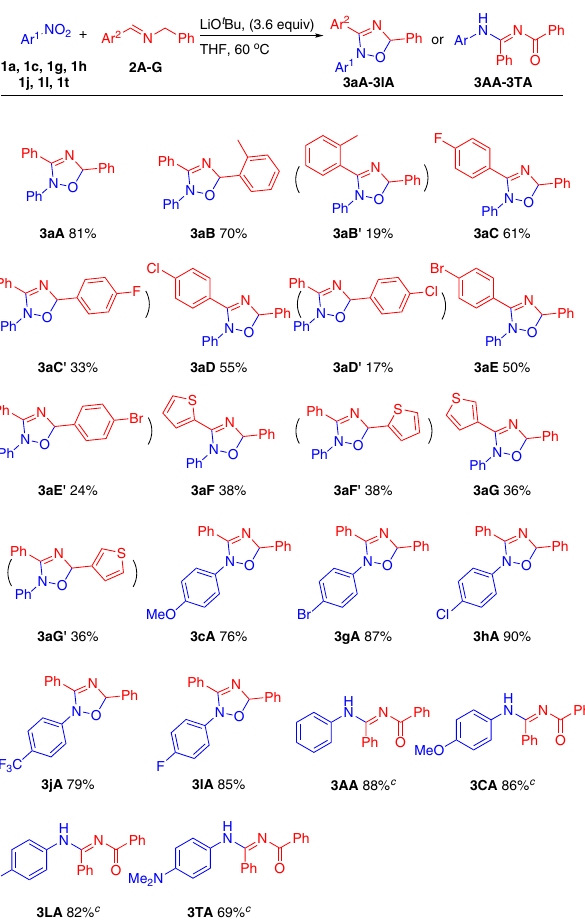
Fig. 5 Substrate scope in the synthesis of triaryl-substituted oxadiazoles and ring-opening products a,b . a Reaction conditions: nitroarene (0.1 mmol), 2a (0.3 mmol), LiO t Bu (0.36 mmol), THF (0.1 M), 60 °C, 12 h. b Isolated yield. c 100 °C.